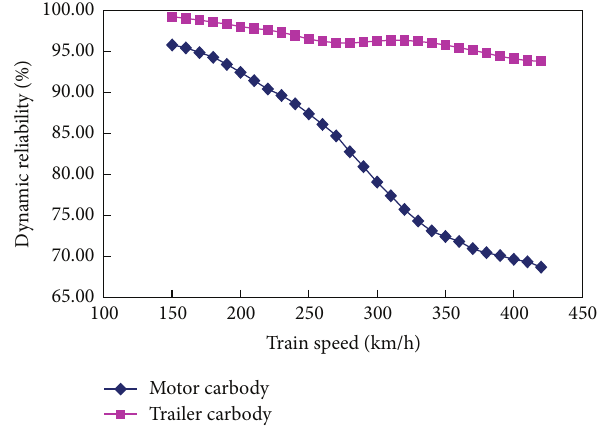
Figure 12: Dynamic reliability for carbody lateral acceleration with respect to train speed.